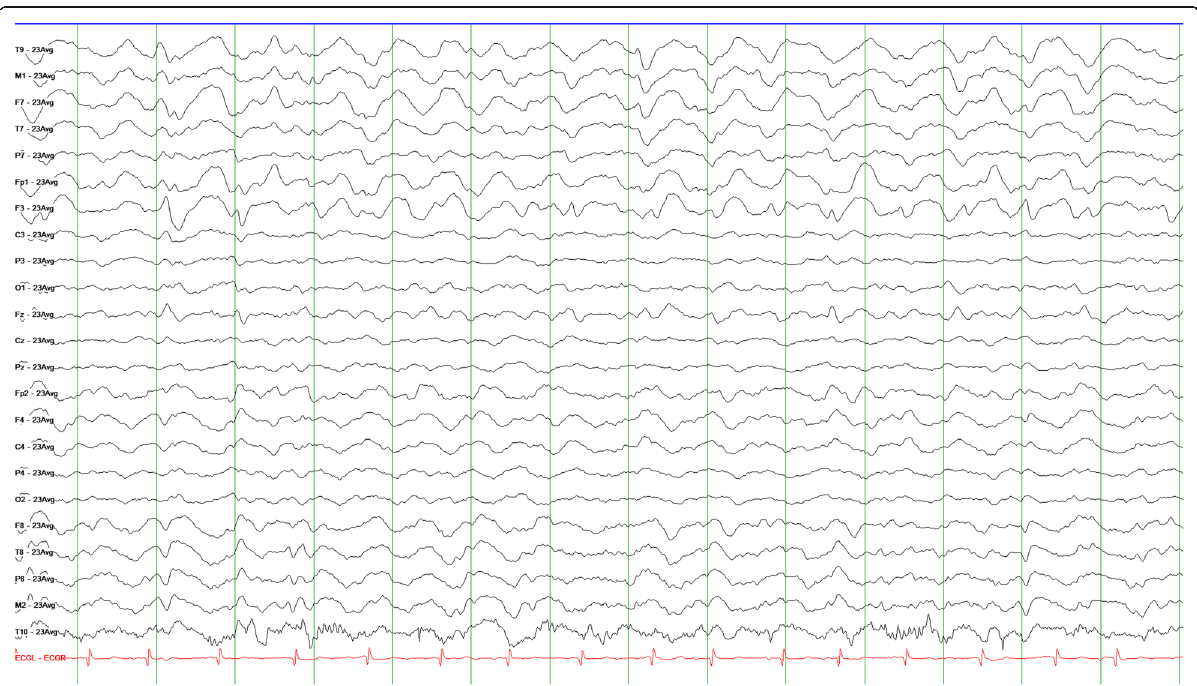
Fig. 3 Lateralized rhythmic delta activity (LRDA) at a frequency of 0.5-1Hz in a patient with metabolic derangement. High pass filter 1 Hz, low pass filter 50 Hz and sensitivity 10